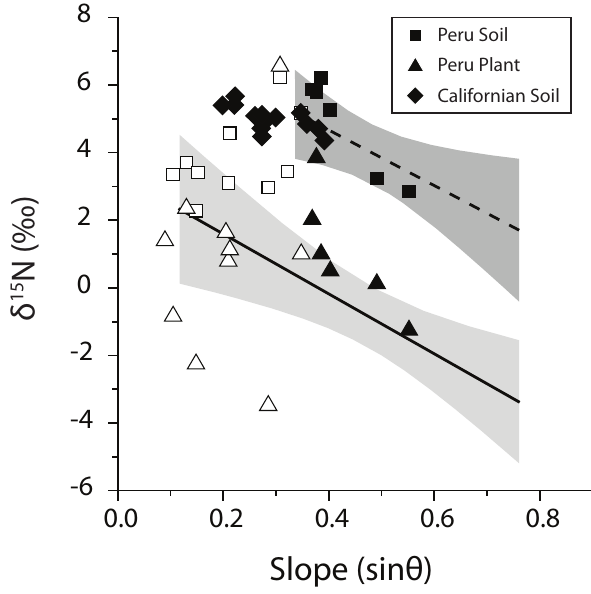
Fig. 5. Mass balance model (Eqs. 1 and 4) predictions of soil δ 15 N at steady state for a forest experiencing N loss by physical erosion of particulate N, at a loss rate k E (yr − 1 ). Lines show model scenarios where the total N loss rate k ex (yr − 1 ) remains constant (black line) and increases (dashed line) as k E increases. The isotopic ratio of inputs ( R ex ) and the fractionation factor of fractioning losses ( α f ) are kept constant with values as shown.